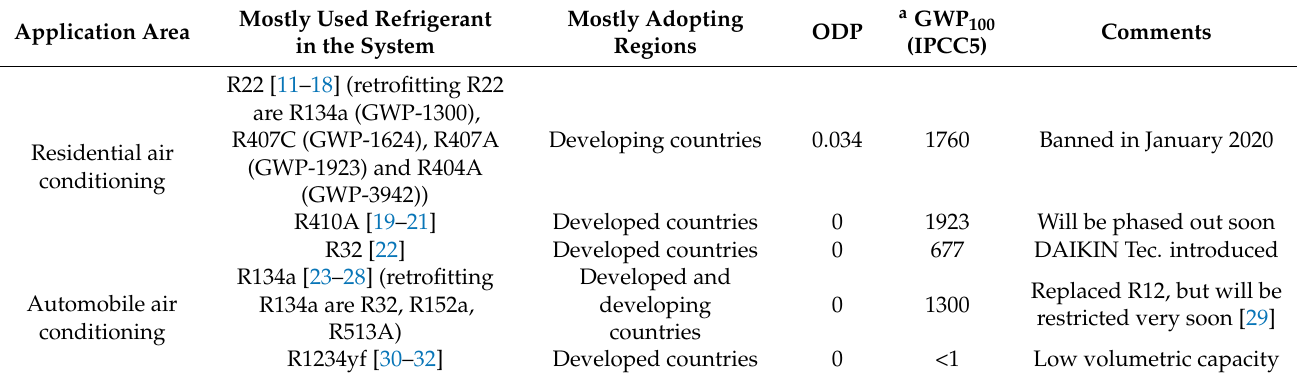
Table 1. Commonly used refrigerants in residential and automobile